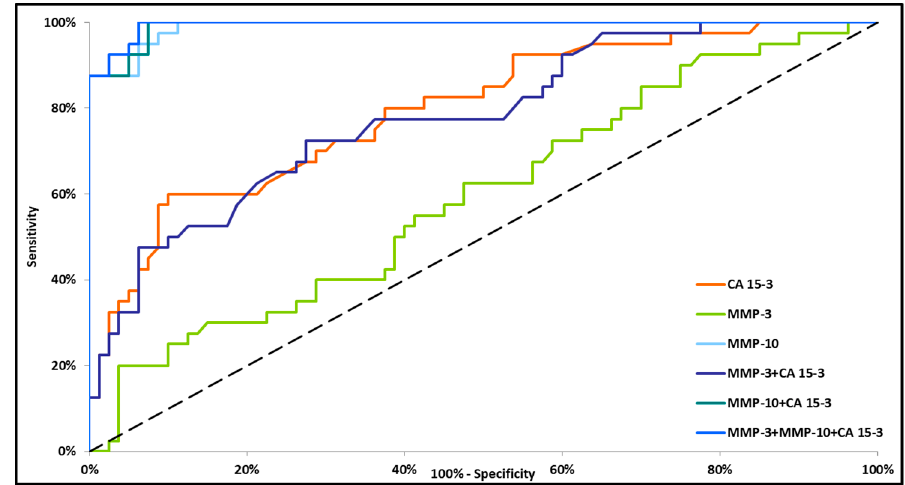
Figure 4. Diagnostic criteria of the ROC curve in stages III and IV BC. CA 15-3—cancer antigen 15-3; MMP-3—stromelysin-1; MMP-10—stromelysin-2.